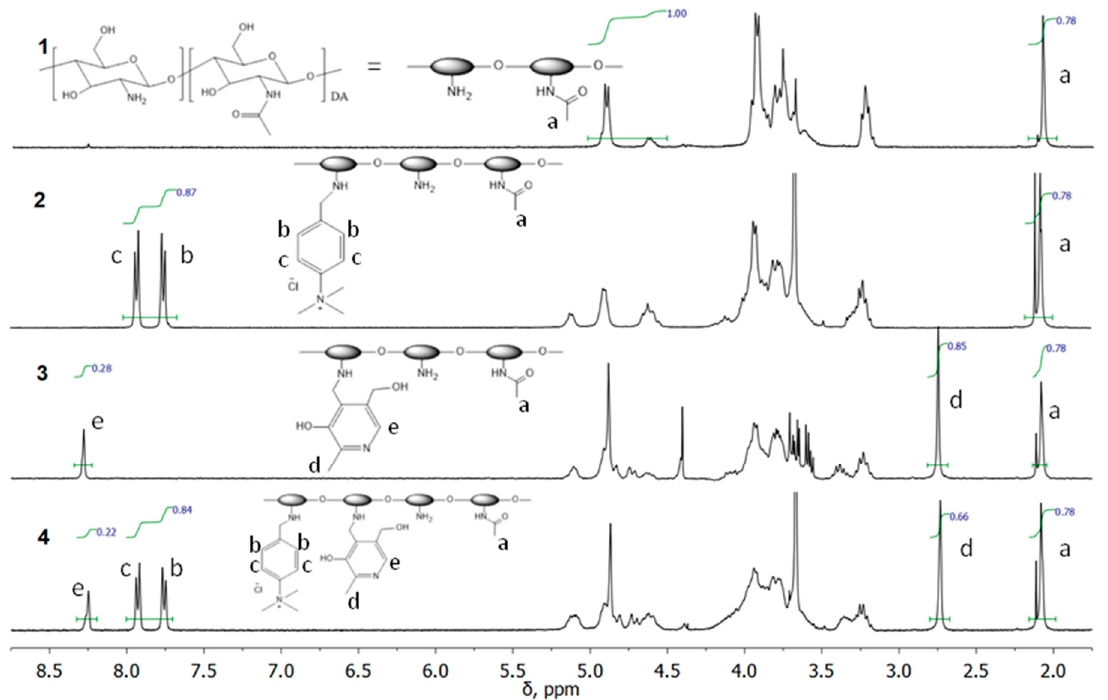
Figure 2. 1 H NMR spectra of CS (1), TMAB-CS (2), Pyr-CS (3), and PyrTMAB-CS (4).